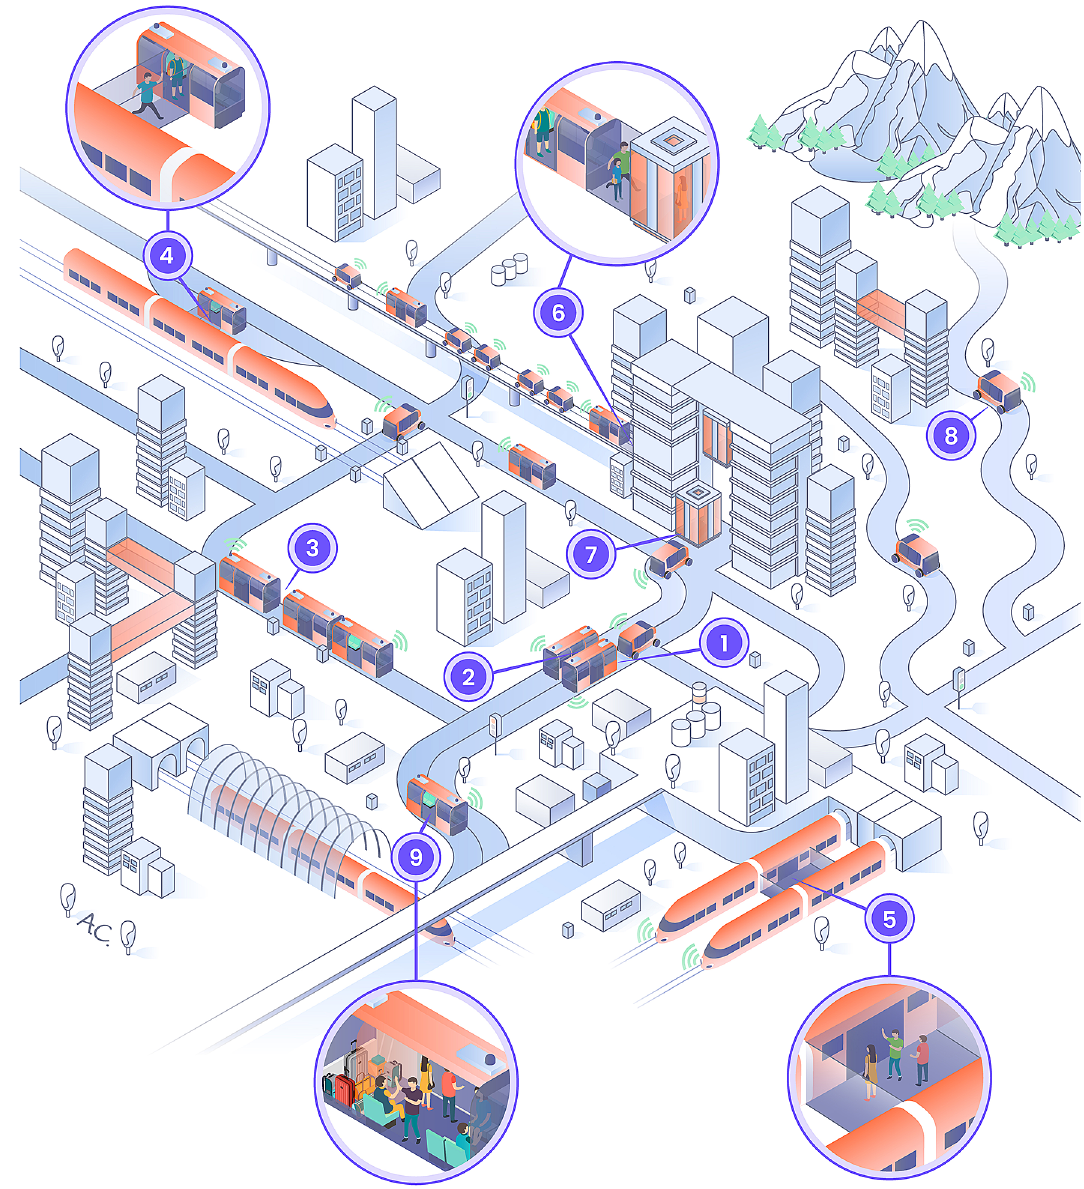
Figure 6. A vision of PT-based seamless urban future mobility. This is a schematic illustration of a feasible urban scenario allowing vehicles to connect to each other physically for smooth transfer of travelers, based on GPPS. Seamless connections of nine vehicles are represented: (1) a longitudinal connection between IAPTV (individual automated PT vehicle) and a small APTV (automated PT vehicle), (2) a lateral connection between two small APTVs, (3) a longitudinal connection between small and large APTVs, (4) a lateral connection between high speed rail and a small APTV, (5) a lateral connection between city and intercity rail, (6) a longitudinal connection between a vertical/diagonal elevator and a small APTV, (7) a longitudinal connection between a horizontal and vertical elevator and a small APTV, (8) a IAPTV journey outside city region, and (9) the flexibility of each APTV to carry goods and